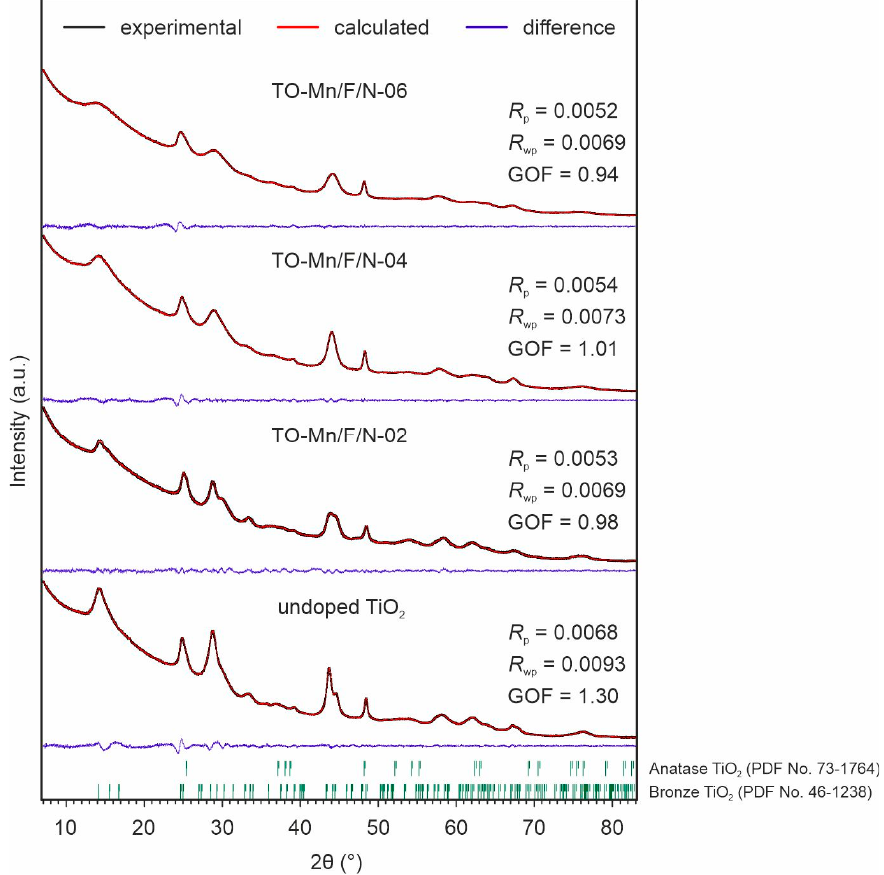
Figure 5. XRD pa tt erns and Rietveld re fi nement results for the unmodi fi ed TiO 2 , TO-Mn/F/N-02, Figure 5. XRD patterns and Rietveld refinement results for the unmodified TiO 2 , TO-Mn/F/N-02, TO-Mn/F/N-04, and TO-Mn/F/N-06 samples. TO-Mn/F/N-04, and TO-Mn/F/N-06